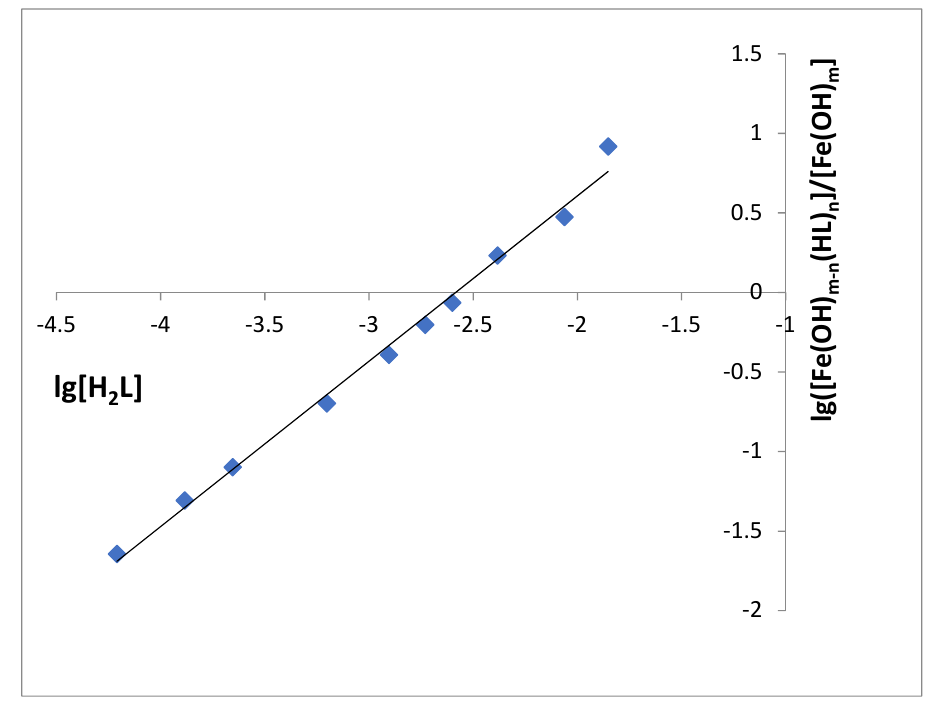
Figure 4. The dependence of lg([Fe(OH) m ‐ n (HL) n ]/[Fe(OH) m ]) on lg[H 2 L]. λ 450 nm, pH 3.3, m (SiFe1)/V = 0.10 g/5.0 mL, time of contact is 60 min.